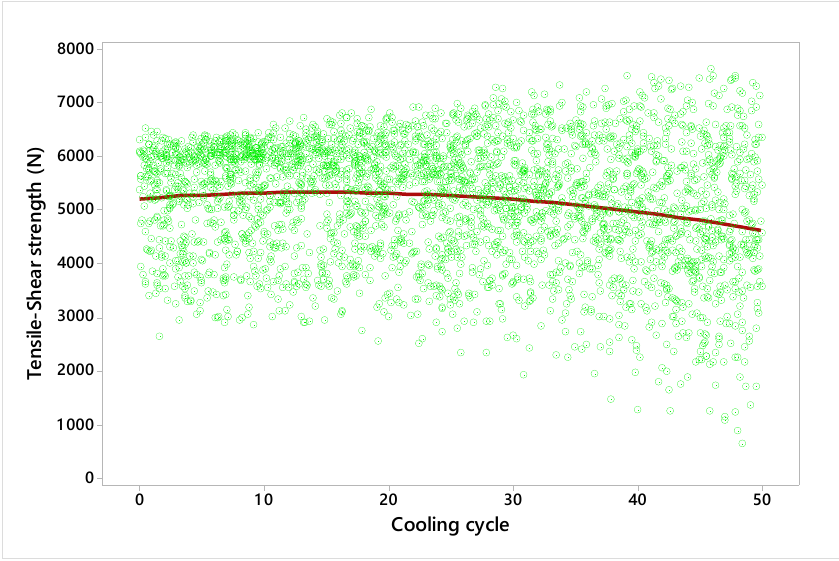
Figure 15. Effect of cooling cycle on TSS of spot welds.